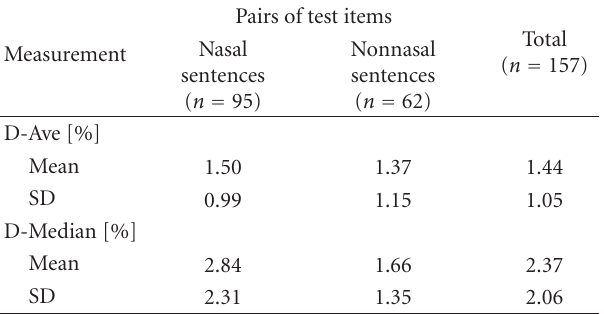
Table 1: Test-retest errors for ave and median nasalance measure-